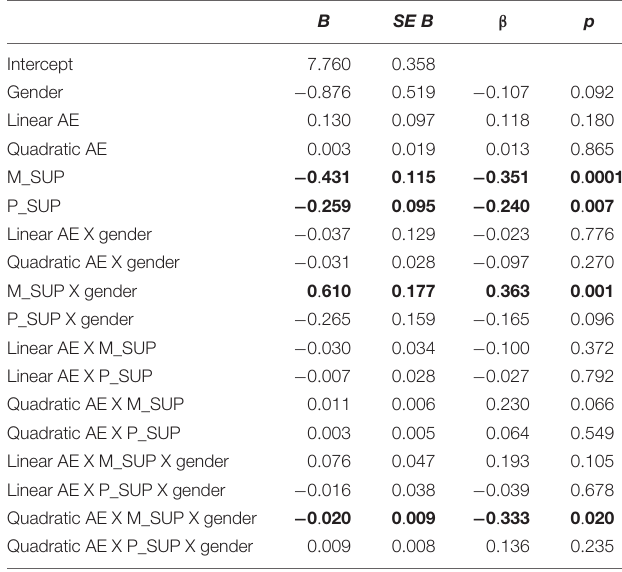
TABLE 3 | Multiple regression analysis with moderating effects of maternal support, paternal support, and gender on the relationship between affective empathy (linear and quadratic) and